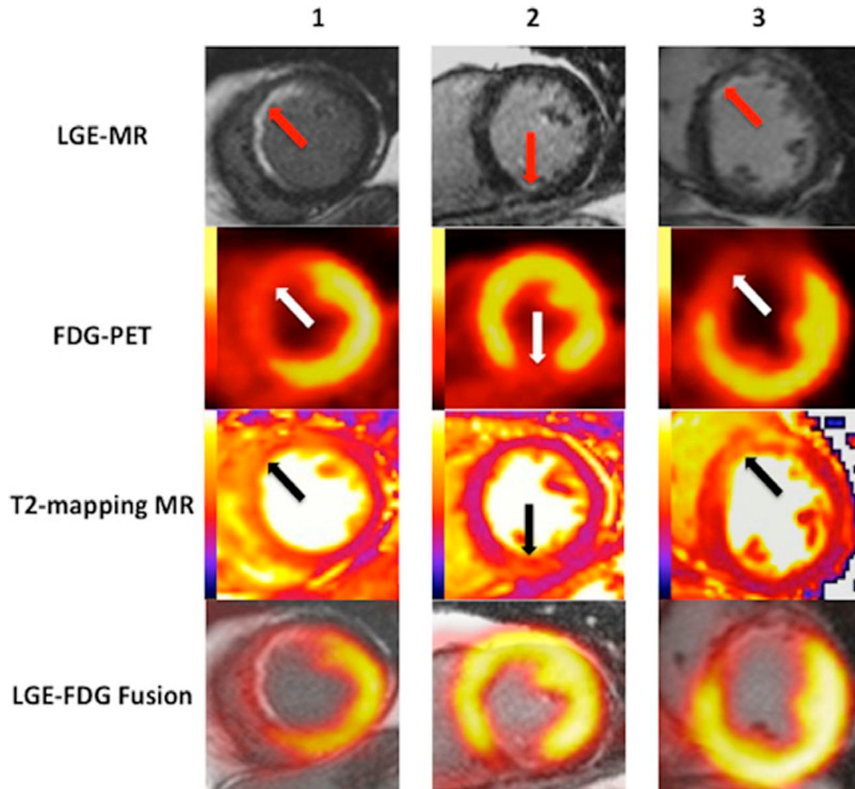
Figure 5. Hybrid PET/CMR imaging of three subendocardial infarctions ( red arrows ) with significant myocardial salvage. In all of the studies, the areas of reduced 18 F-FDG uptake ( black arrows ) and of increased T2 mapping ( white arrows ) extended beyond the areas of LGE. In Study 2, the area of reduced 18 F-FDG uptake is substantially larger than the area of LGE and more closely matched the T2 map. The follow-up scan confirms the presence of myocardial salvage, in which in area of reduced 18 F-FDG uptake decreases in size and matches the areas of infarction. Reproduced from Bulluck et al., 2016, by permission of Circ. Cardiovasc. Imaging [123].